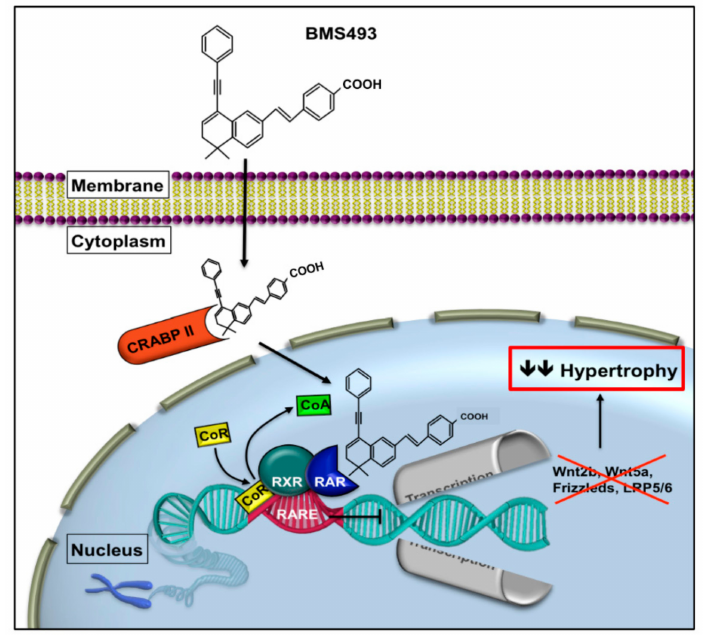
Figure 2. Schematic demonstration of the inhibition of the RAR pathway by BMS. BMS is translocated into the nucleus by the cellular retinoic acid binding protein II (CRABP II) and binds to the RAR / RXR complex. Binding of the inverse agonist supports corepressor recruitment. The receptor complex subsequently inhibits target gene expression at the promoter area RARE. The consequently reduced expression of Wnts and Wnt receptors and coreceptors decreases hypertrophic di ff erentiation [29,43,44]. RAR, retinoic acid receptor; RXR, retinoic X receptor; CRABP II, cellular retinoic acid binding protein; RARE, retinoic acid response element; CoA, co-activator; CoR, co-repressor; LRP, lipoprotein receptor related protein; LEF / TCF, lymphoid enhancer binding factor / transcription factor, ↓↓